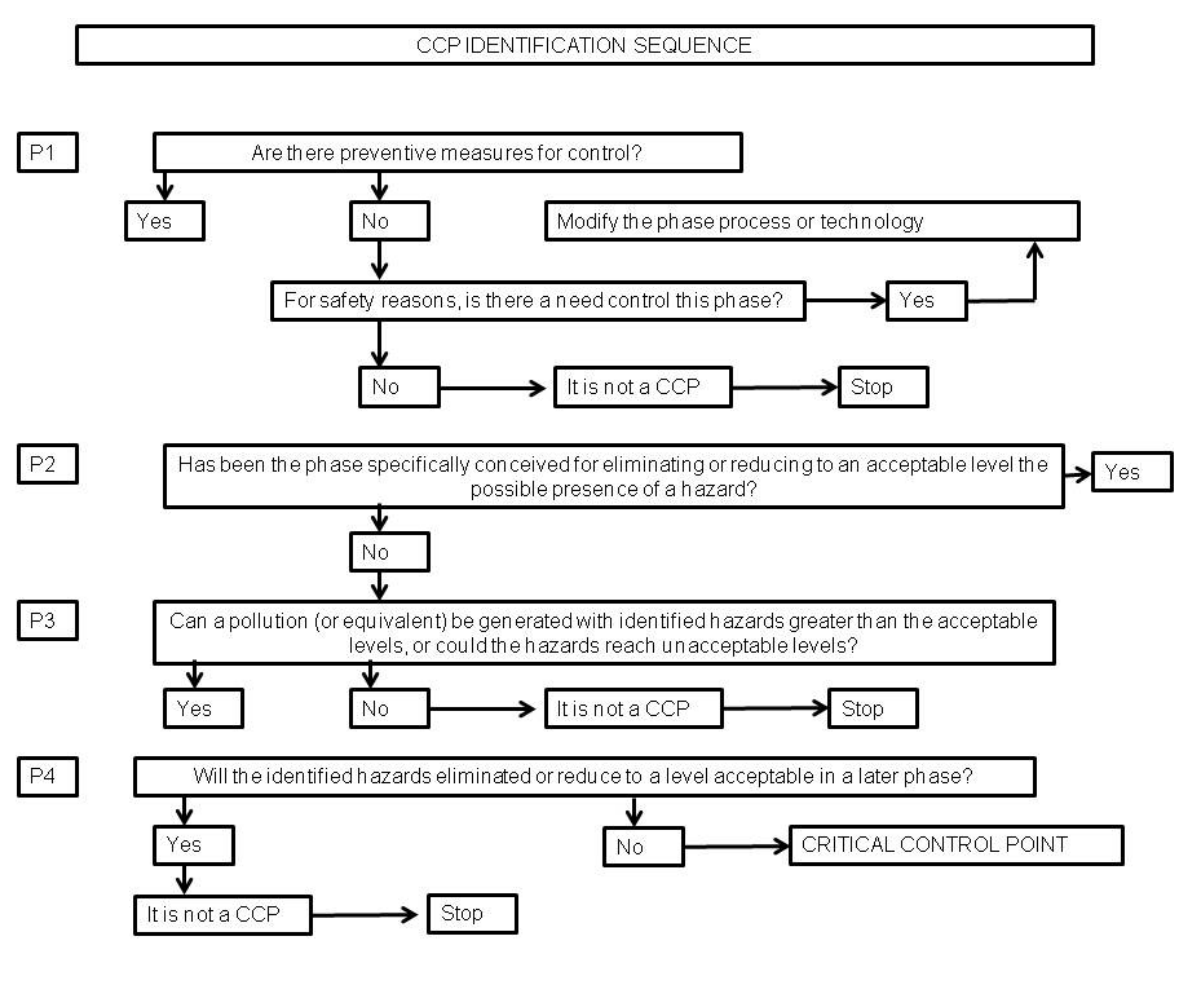
Figure 2. Guideline for the identification of